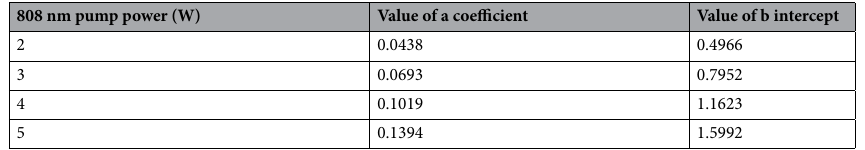
Table 1. The value of the coefficient and intercept of the logarithmic relation for 532 nm that was obtained for each value of 808 nm pump power in Watts.